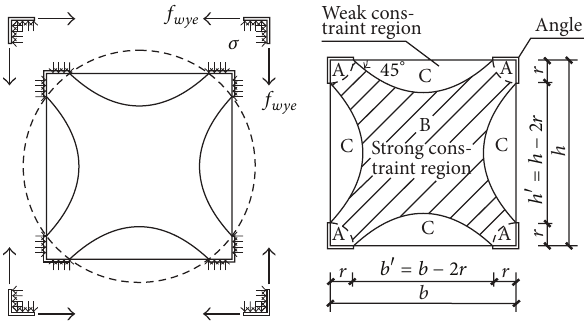
Figure 5: Stress distribution at the cross section of the strengthened